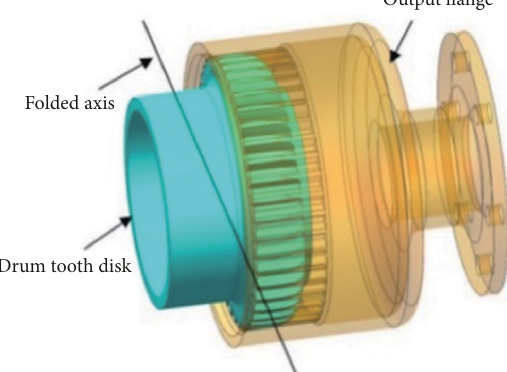
Figure 2: Diagram of the engagement of the crown gear coupling.